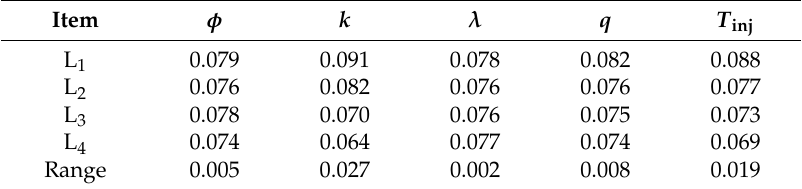
Table 8. Mean effects of different levels of conditions on the reservoir impedance at t = 20 years. Item φ